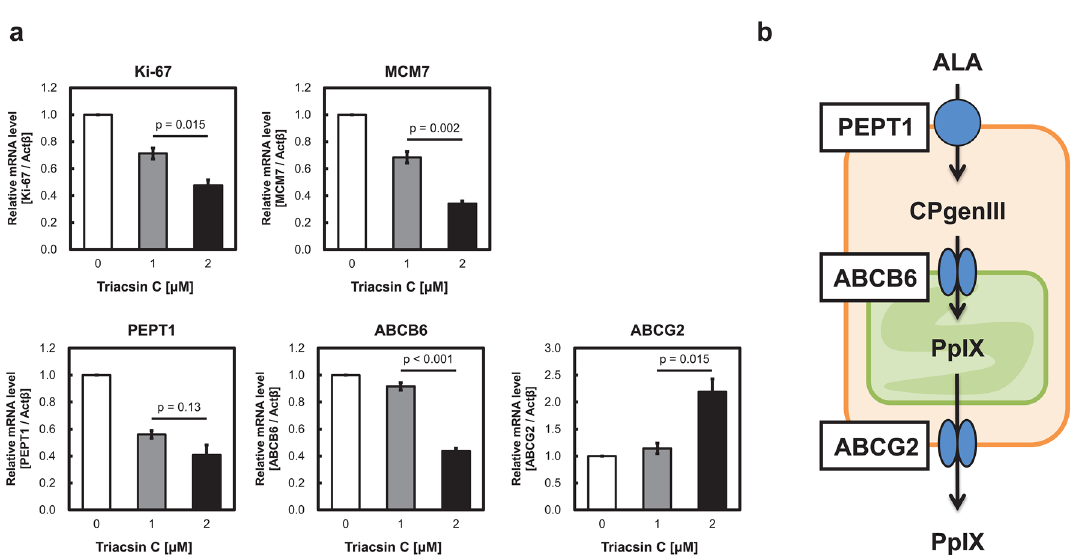
Figure 4. mRNA expression changes induced by triacsin C treatment. ( a ) The mRNA expression levels of the cell proliferation markers Ki-67 and MCM7 and porphyrin-related transporters PEPT1, ABCB6, and ABCG2 were measured. The cells were treated with triacsin C for 72 h. n = 3. Bars represent the SE. ( b ) Dominant transporters involved in porphyrin